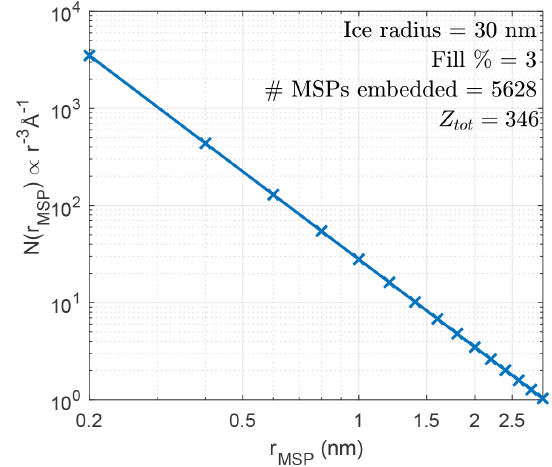
Figure 2. Size distribution of parameterized MSP particles inside an ice particle of size 30nm. Note that Z tot is the upper bound on charge production for the case of complete charging of fragments. Annotated values show the result of employing our charging model on such a